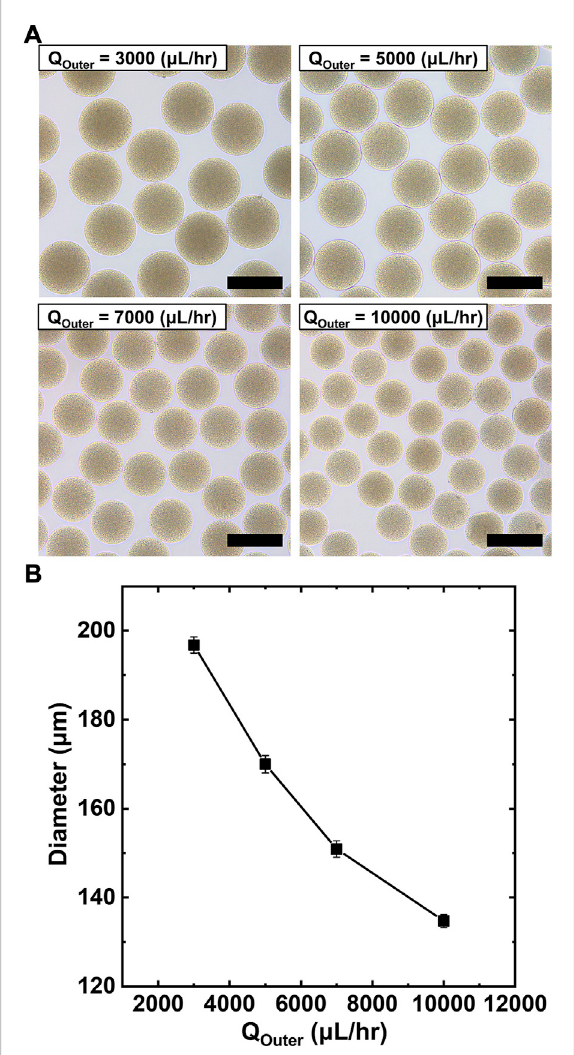
tunable size. (A) Bright- fi eldmicrographs showing thetunable size of microgels at varying fl ow rates of outer phase. (B) Plot